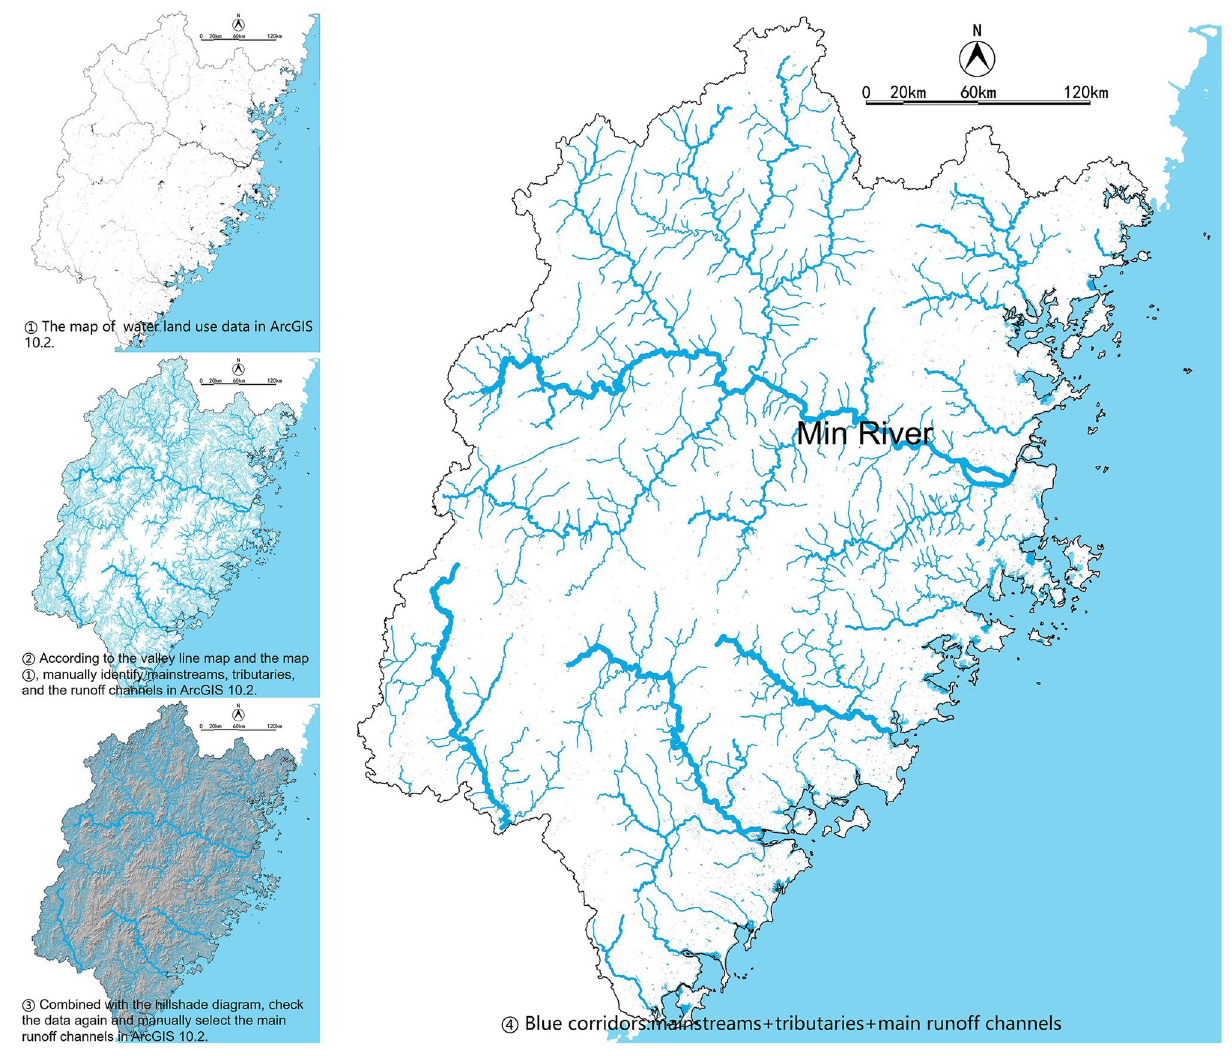
Figure 14. Blue corridors of the Fujian